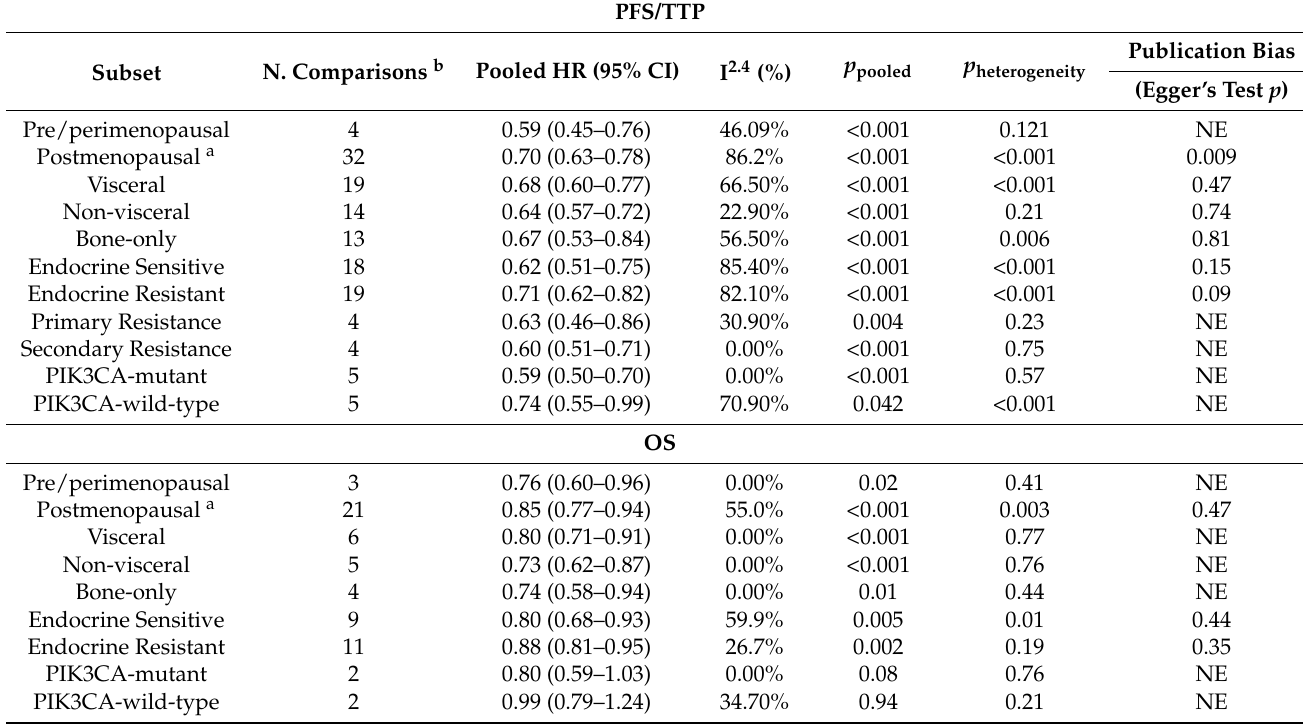
Table 1. PFS and OS pooled results according to each patients’ subgroup.